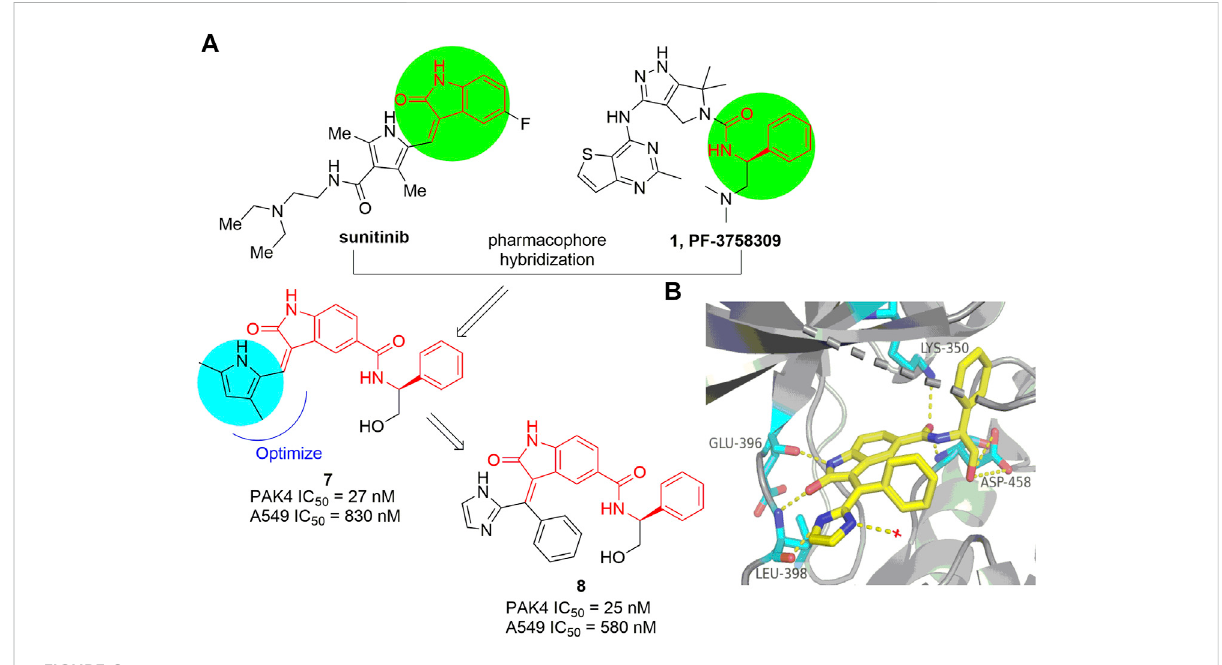
(Figure 7D). In HCT-116 and B16F10 xenograft models, oral administration of 12 at 50 mg/kg signi fi cantly suppressed the tumor growth with inhibition rates of 65% and 63%, respectively in the two mice models (Guo et al.,